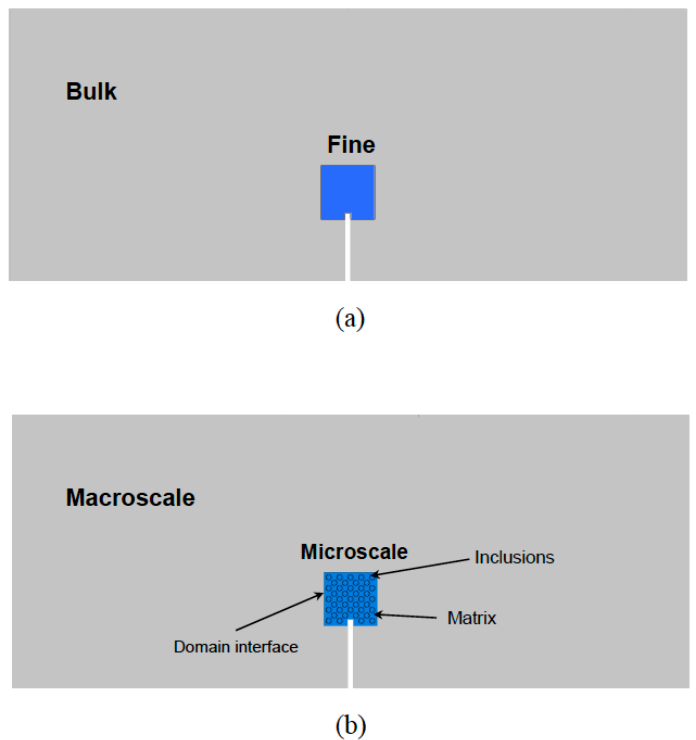
Figure 21. The domain decomposition method is a generic numerical technique that allows the interaction between different subdomains. For instance, it can be used to define one domain with bulk properties and another with homogenized properties ( a ). In the case of multiscale modeling, one subdomain corresponds to the macroscale model which interacts with the microscale model (matrix with cylindrical inclusions) through the interface ( b ). These figures correspond to a three-point bending test in notched specimens of a metal-matrix composite.